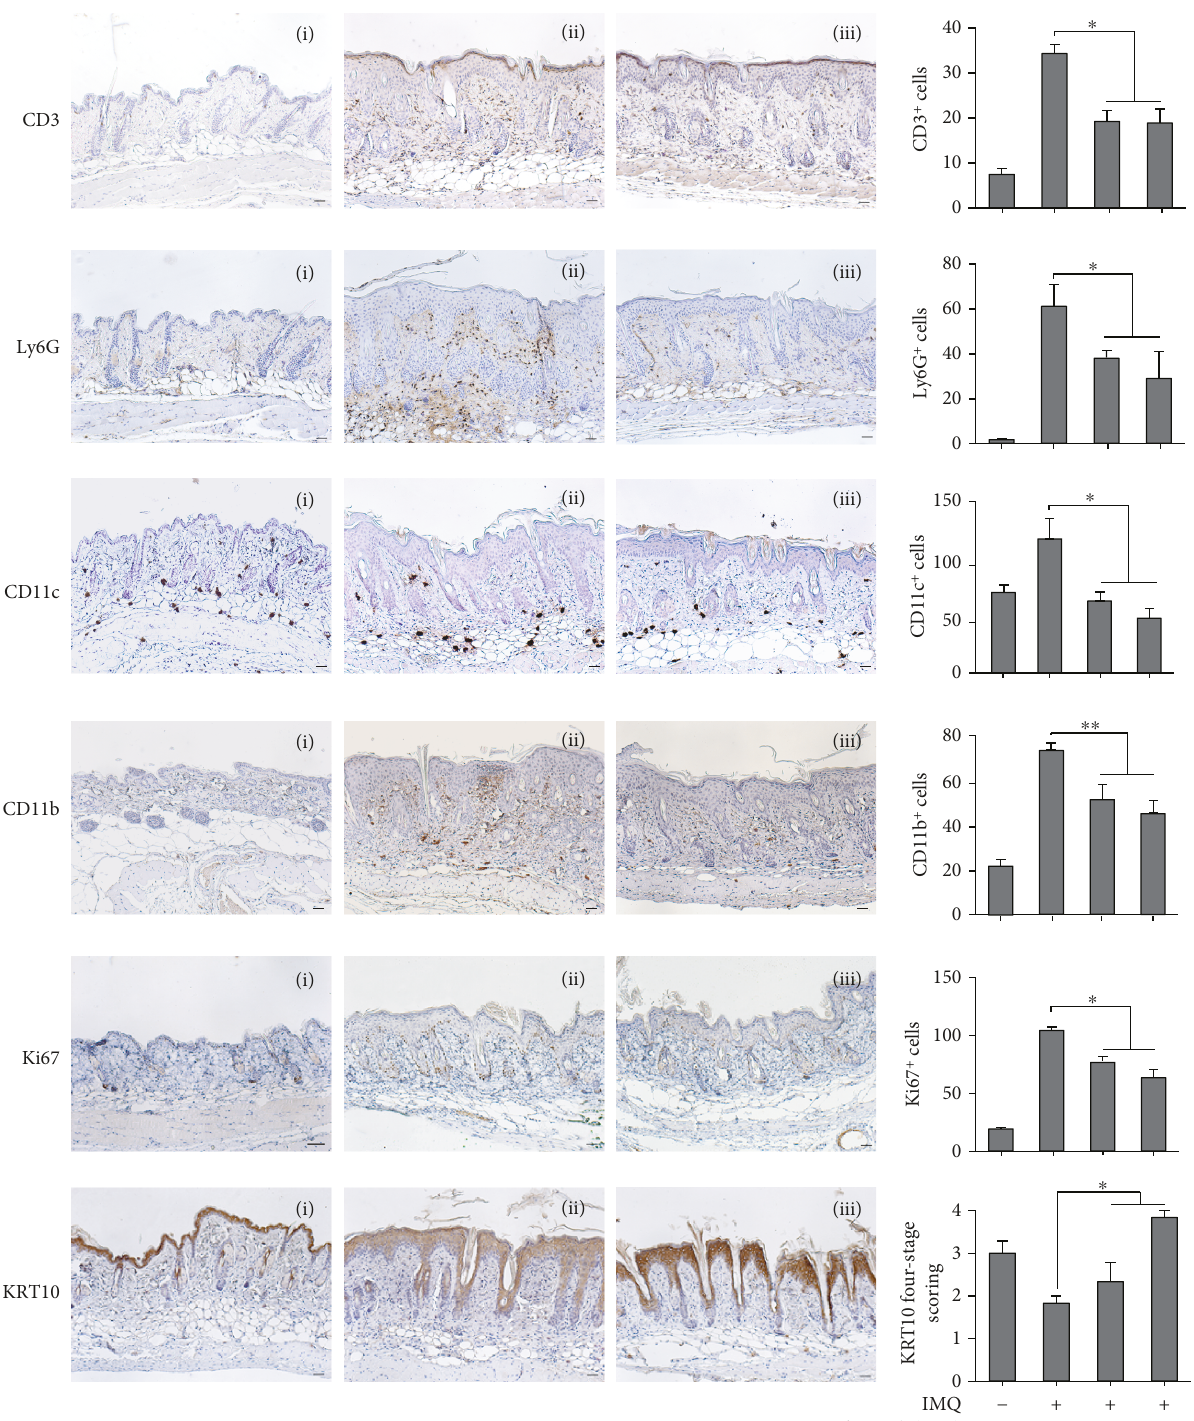
Figure 5: Tofacitinib counteracts IMQ-induced leukocyte in fi ltration, proliferation, and dedi ff erentiation in mouse skin. Immunohistochemistry analysis of mouse skin left untreated (i), IMQ-treated (ii), and IMQ-treated in the presence of tofacitinib (iii) shows reduction of positive CD3, LY6G, Ki67, CD11c, and CD11b cells and an increase of KRT10 in the epidermis after tofacitinib treatment. Sections were counterstained with Mayer ’ s hematoxylin and were visually evaluated by a pathologist experienced in dermatology. Bars, 200 μ M. One of four representative stainings is shown. Graphs show the mean of number of positive cells or of semiquantitative, four-stage scoring values for KRT10 ± SD per three sections per experimental group ( n = 10 mice). ∗ p < 0 01 , ∗∗ p < 0 001